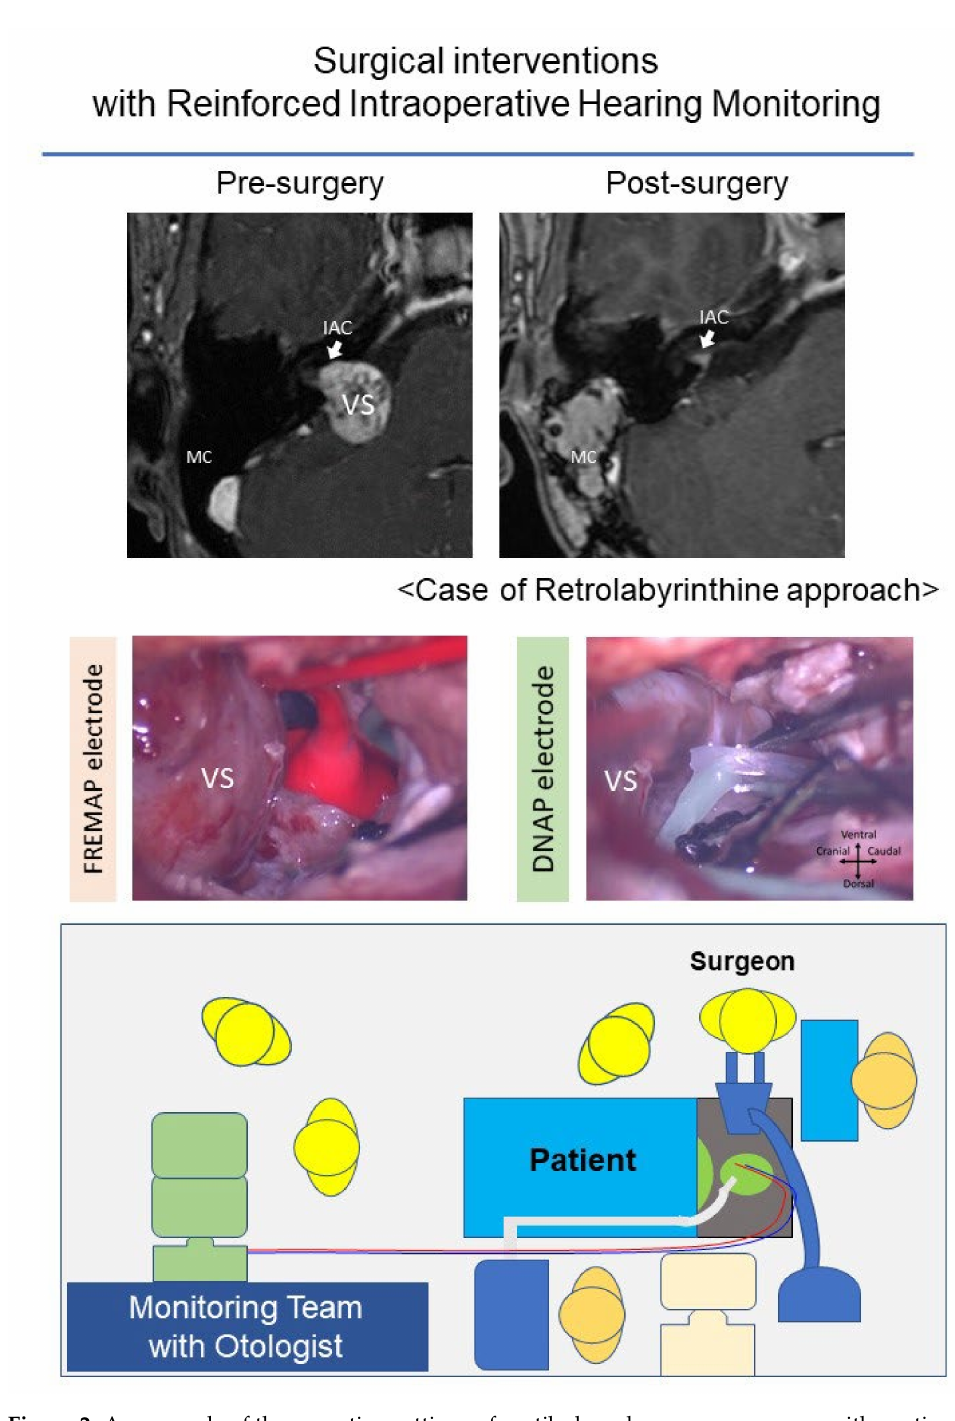
Figure 2. An example of the operation settings of vestibular schwannoma surgery with continuous monitoring (case of right-sided vestibular schwannoma). Combining intraoperative continuous monitoring systems with one of the hearing preservation surgeries is an effective approach to reduce the risk of hearing loss. This figure shows an example of a combination of the retrolabyrinthine approach and the FREMAP/DNAP monitoring system. After opening the dura in the cisternal portion, electrodes of FREMAP and DNAP are placed to monitor facial nerve function and hearing. If any changes in the monitoring are detected, caution should be noted by the team, which usually includes an otologist. These cautions are helpful for surgeons to avoid unintended damage to the nerves. VS: vestibular schwannoma, IAC: internal auditory canal, MC: mastoid